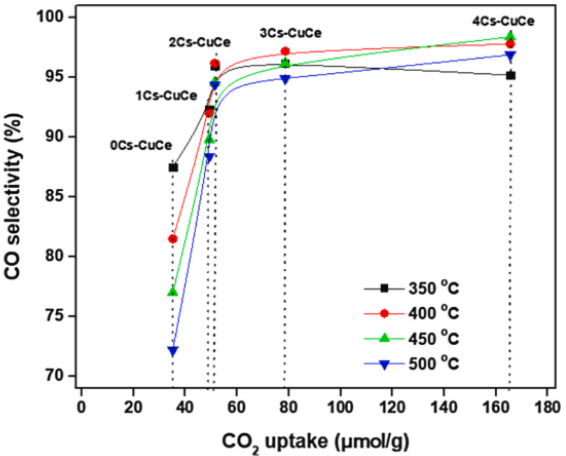
Figure 25. Correlation between CO selectivity, Cs content and total basicity of the samples in various Cs-doped Cu/CeO 2 catalysts. Reproduced with permission from Ref. [201]. Copyright© 2021, Elsevier.